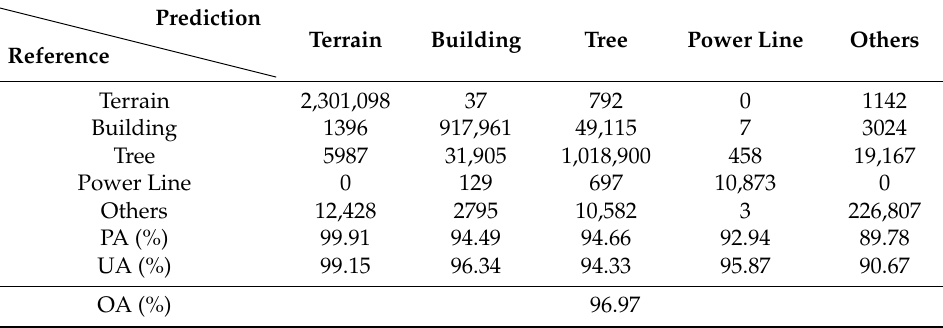
Figure 3. Multi-class classification results of presence and background learning algorithm implemented by back propagation neural network (PBL-BP) and support vector machine (SVM): ( a ) PBL-BP; ( b ) SVM. Table 2. Confusion matrix for the PBL-BP multi-class classification result.